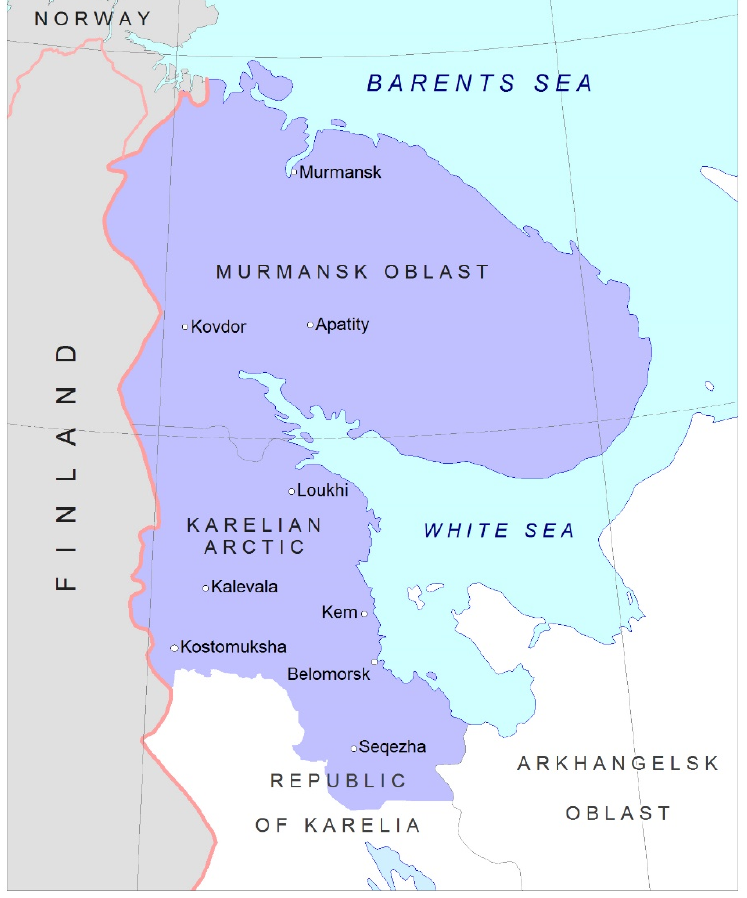
Figure 1. The region of the study.